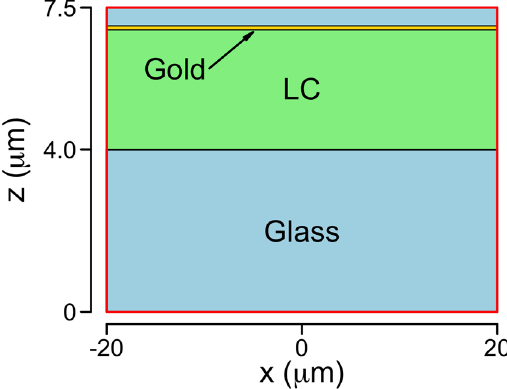
Figure 5. Geometry of the optrode wave optics simulations. The simulation domain is indicated by the red rectangle. Coloured regions represent the different materials (LC: liquid cyrstal). The light blue area at the top is glass, with a 60 nm thick gold layer located at z = 7 μ m.